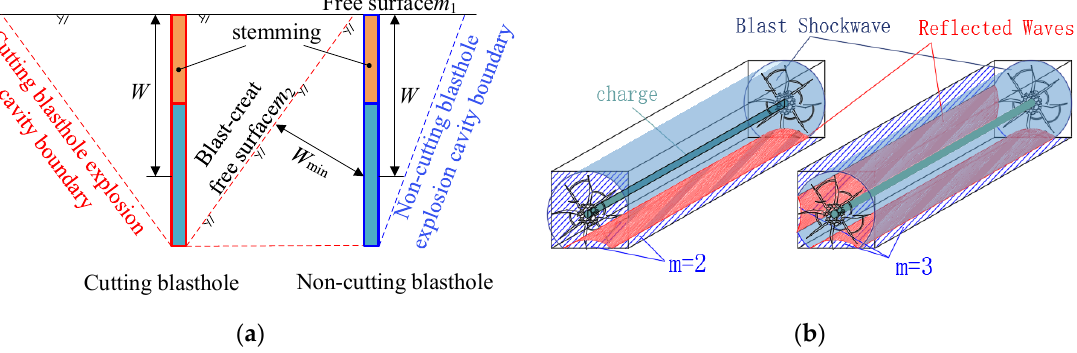
Figure 5. Schematic diagram of blasting of different blasting holes in the tunnel: ( a ) Burden variation. ( b ) Free surface variation.